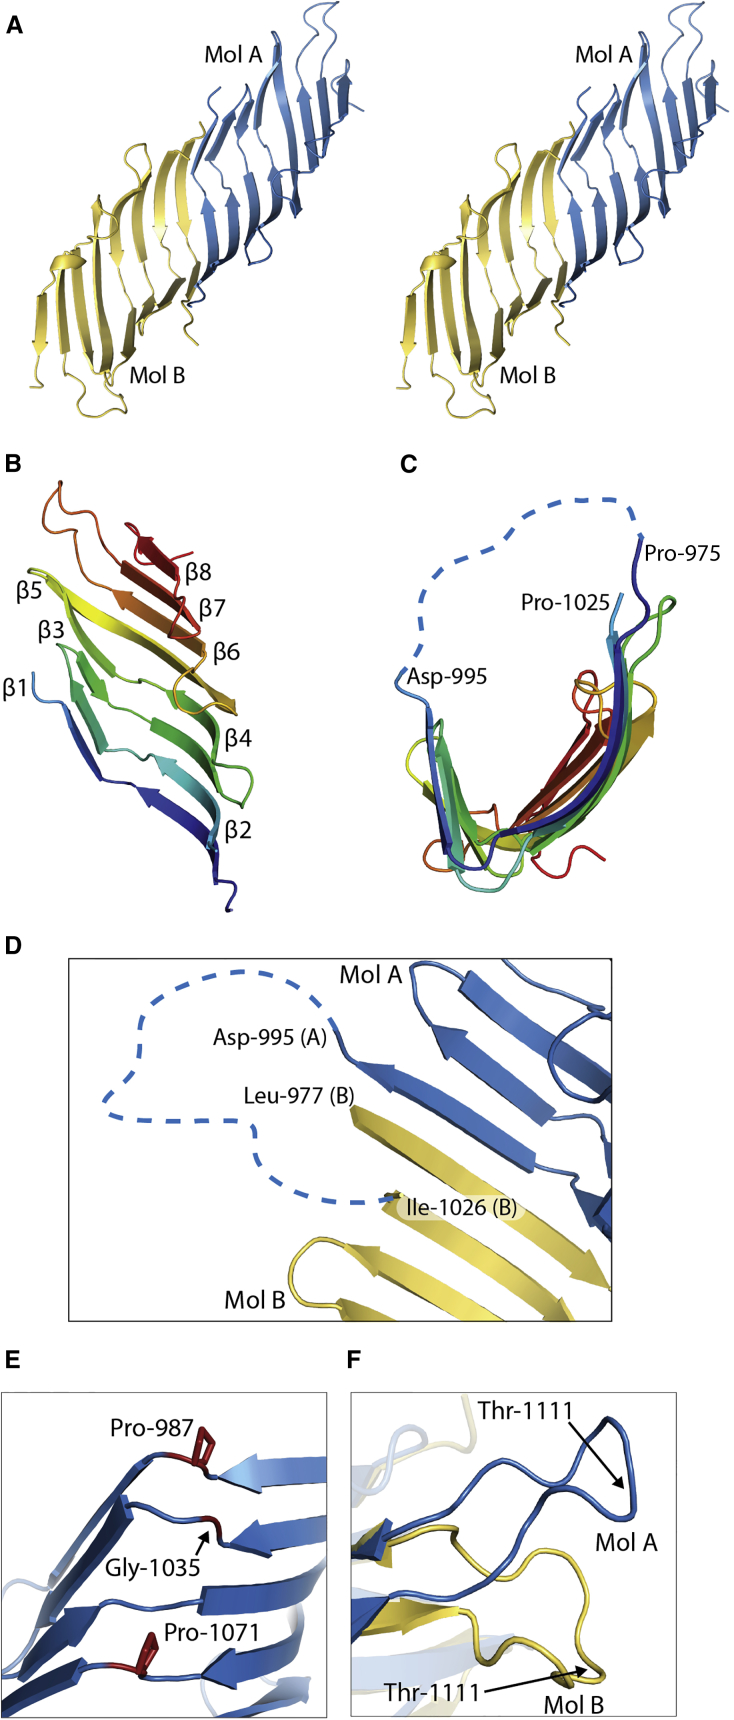
The Crystal Structure of TamB963-1138(A) Cross-eye stereo view of the TamB963-1138 dimer; molecule A is colored blue and molecule B is colored yellow.(B) Jones's Rainbow of TamB963-1138, colored from blue (N terminus) to red (C terminus).(C) TamB963-1138 showing disordered region connectivity option one between Asp995 and Pro1025 of molecule A.(D) TamB963-1138 showing connectivity option two between Asp995 of molecule A and Ile1026 of molecule B.(E) The kink at the base of the TamB963-1138 β taco is created by Pro987 and Pro1071 and Gly1035.(F) A large conformational difference is observed in the loop between β strands 6 and 7 of TamB963-1138 molecule A and B.